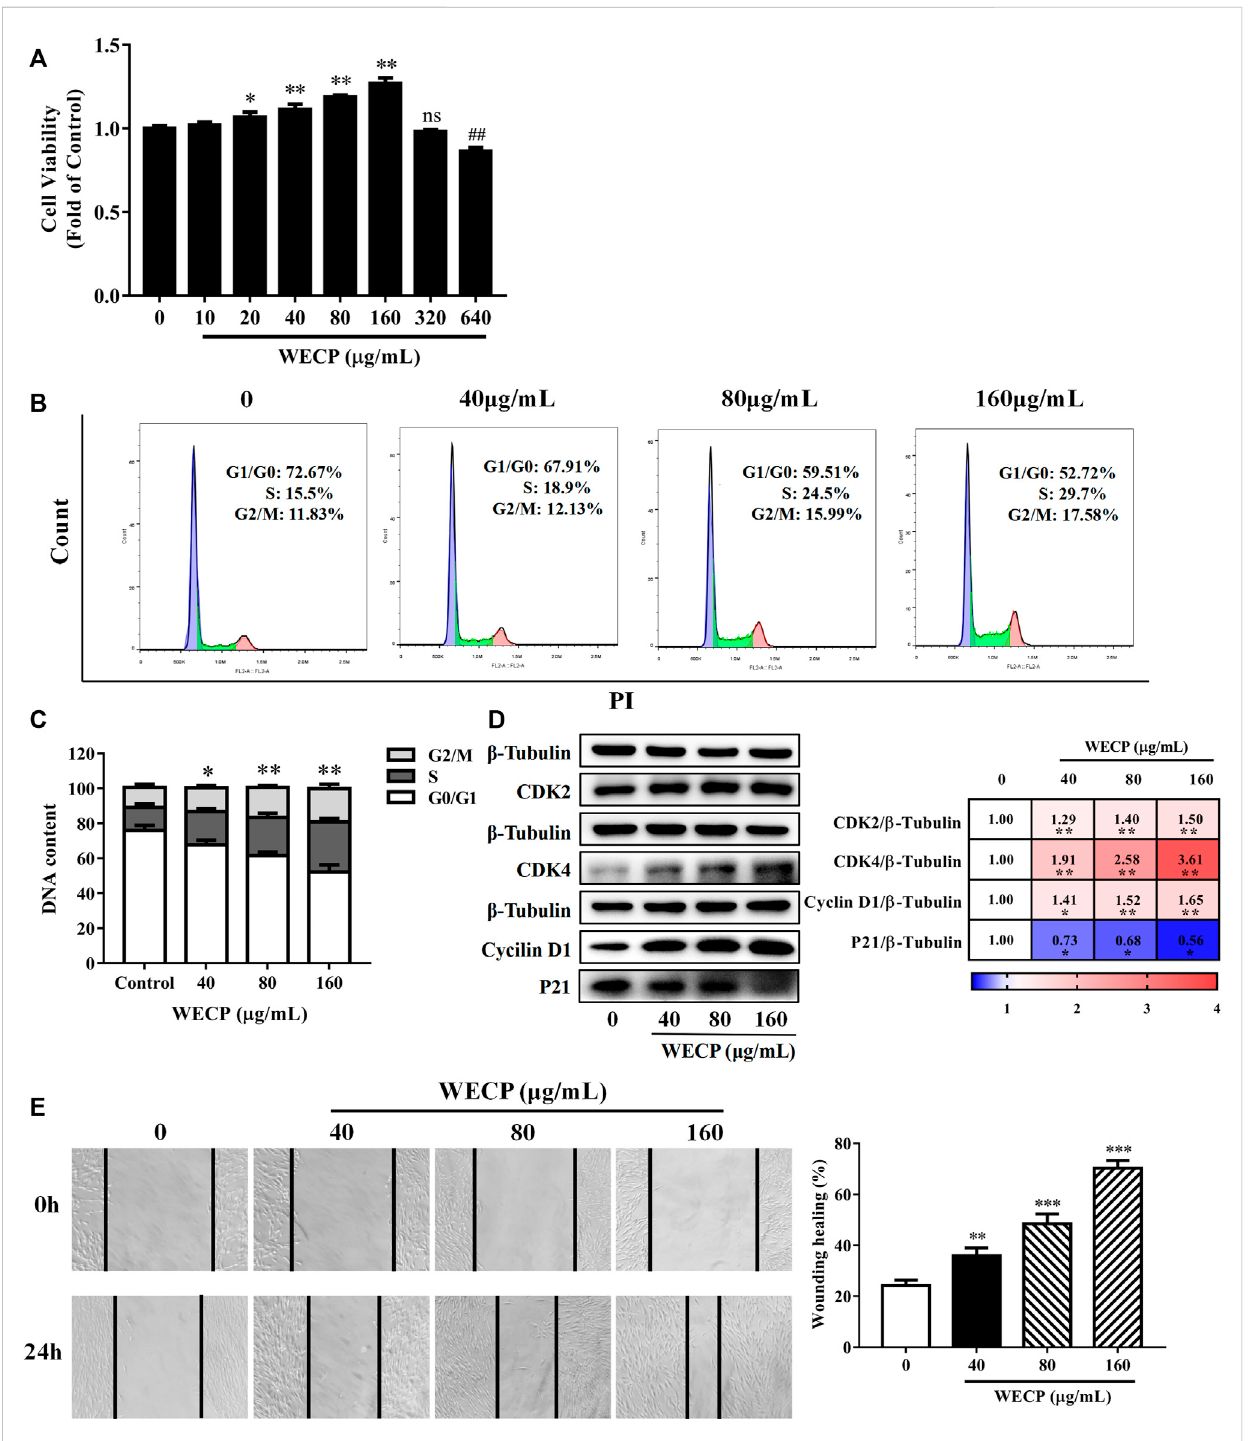
WECP increased DPC proliferation and migration. (A) Cell proliferation was measured using the CCK-8 assay. DPCs were treated with various concentrations of WECP (10, 20, 40, 80, 160, 320 and 640 μ g/mL). Data were means of three independent experiments. Error bars represent standard deviation (SD). * p < 0.05, and ** p < 0.01 vs. vehicle-treated control. DPCs were treated with WECP (40, 80, and 160 μ g/mL) for 24 h. (B) Distribution of DPCs in G1, S, and G2 after WECP treatment detected using fl ow cytometry and (C) quantitatively analyzed using FlowJo v. 10.0.7r2. (D) Expression of cell cycle-related proteins was determined by western blotting after WECP treatment. (E) Effects of 24 h WECP treatment on DPC migration were observed and quanti fi ed. Data were means ± SD of three independent experiments. * p < 0.05, ** p or ## p < 0.01 and *** p < 0.001 vs. control. NS, not signi fi